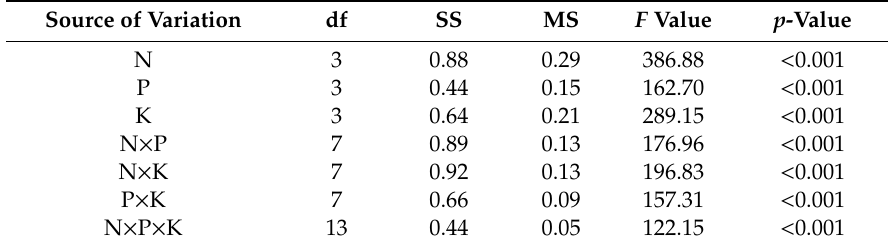
Table 5. ANOVA of the “3414” Phoebe bournei seedling growth response in the fertilization experiment, as defined by a measure of the seedling quality index (QI).